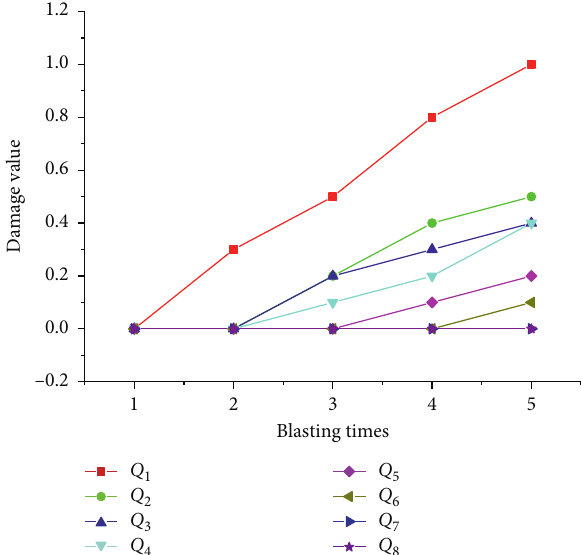
Figure 12: The curve of the relationship between cumulative damage of rock anchor beam monitoring points along the axis of powerhouse and blasting times.